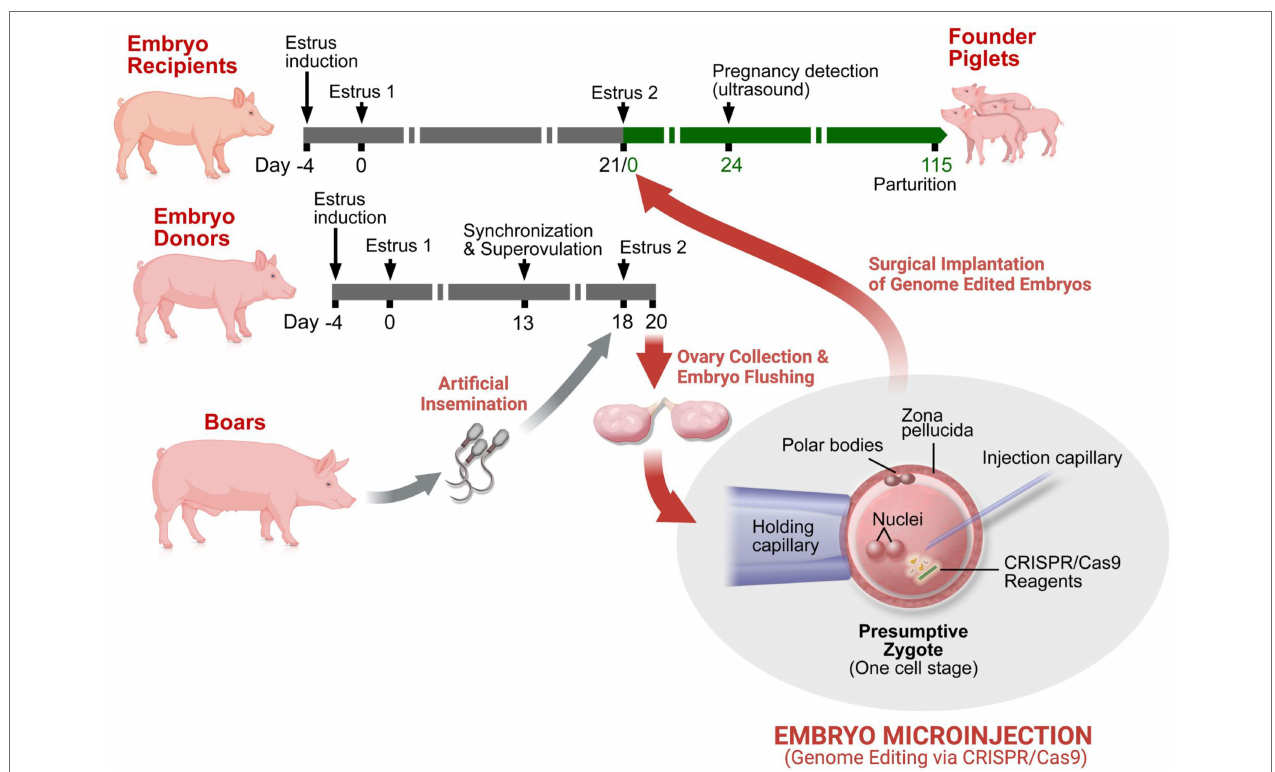
FIGURE 1 | Genetic engineering of pigs by embryo microinjection. Estrus synchronization of potential embryo recipient (surrogate pigs) and donor pigs is achieved by a refined hormone regimen. A variation in the regimen is utilized in the embryo donors to increase ovulation rate and the potential for higher yield of one-cell embryos (zygotes). The embryo donors are artificially inseminated on second estrus detection and euthanized shortly thereafter for collection of single-cell presumptive zygotes. The isolated zygotes are microinjected with the CRISPR/Cas9 components and implanted into the oviducts of surrogate pigs by surgical access usually within 4–6 h of initial embryo collection. Transabdominal ultrasound is used to confirm pregnancy and to track fetal development. Shortly after parturition, genomic DNA is obtained from the neonatal piglets for genotypic validation and identification of genetically engineered “founders” for subsequent breeding and expansion of the novel swine